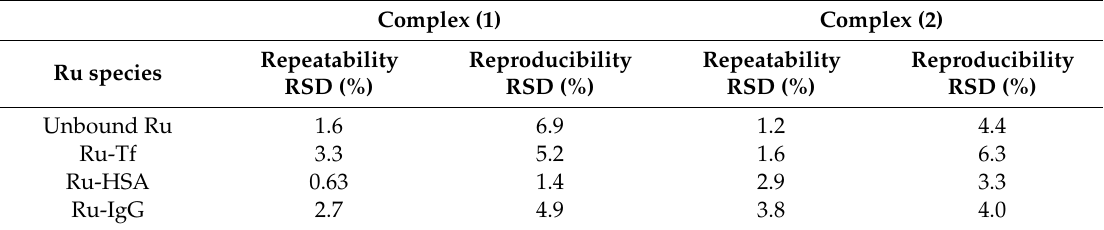
Table 2. Repeatability and reproducibility of measurement for speciation of Ru in serum sample spiked with complexes ( 1 ) (4.14 µ g / mL Ru) or ( 2 ) (0.838 µ g / mL Ru) on CLC column.